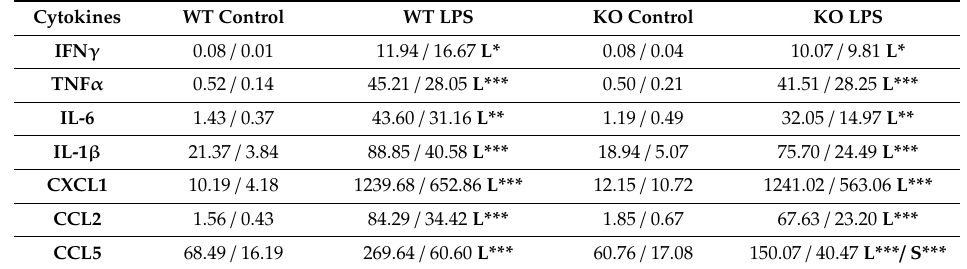
Table 2. Inflammatory cytokine expression in lung tissue. Cytokine expression was normalized to total tissue protein concentration (pg / mg) and is displayed as mean / SD. L = significant LPS e ff ect in the respective strain group, S = significant strain e ff ect in respective exposure group; * p < 0.05, ** p < 0.01, *** p <